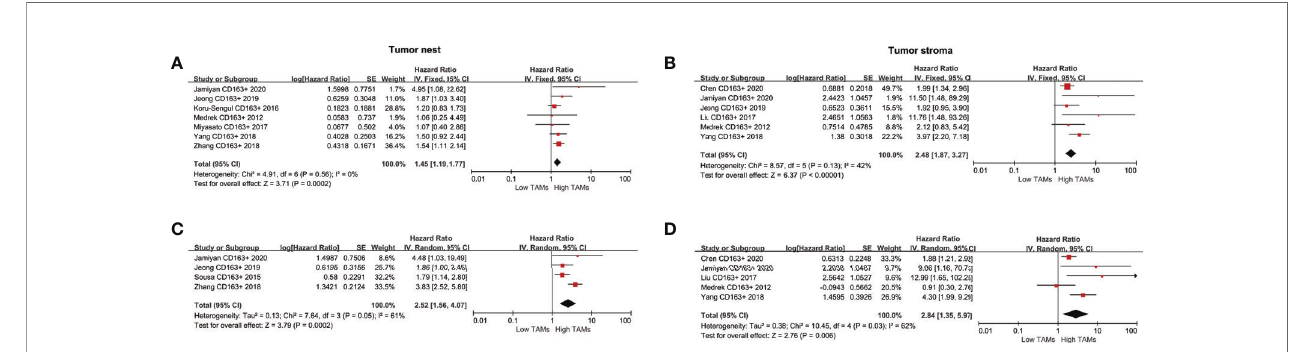
FIGURE 5 | Forest plots of HRs for DFS between high and low CD163+ TAM density in BCa patients. (A) HRs of DFS in raw data for CD163+ TAMs in the TN of BCa; (B) HRs of DFS in raw data for CD163+ TAMs in the TS of BCa; (C) HRs of DFS with adjusted measures for CD163+ TAMs in the TN of BCa; (D) HRs of DFS with adjusted measures for CD163+ TAMs in the TS